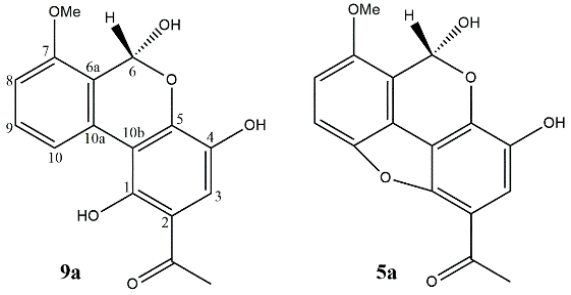
Figure 4. Structures of alternethanoxin A ( 9a ) and alternethanoxin B ( 5a ).